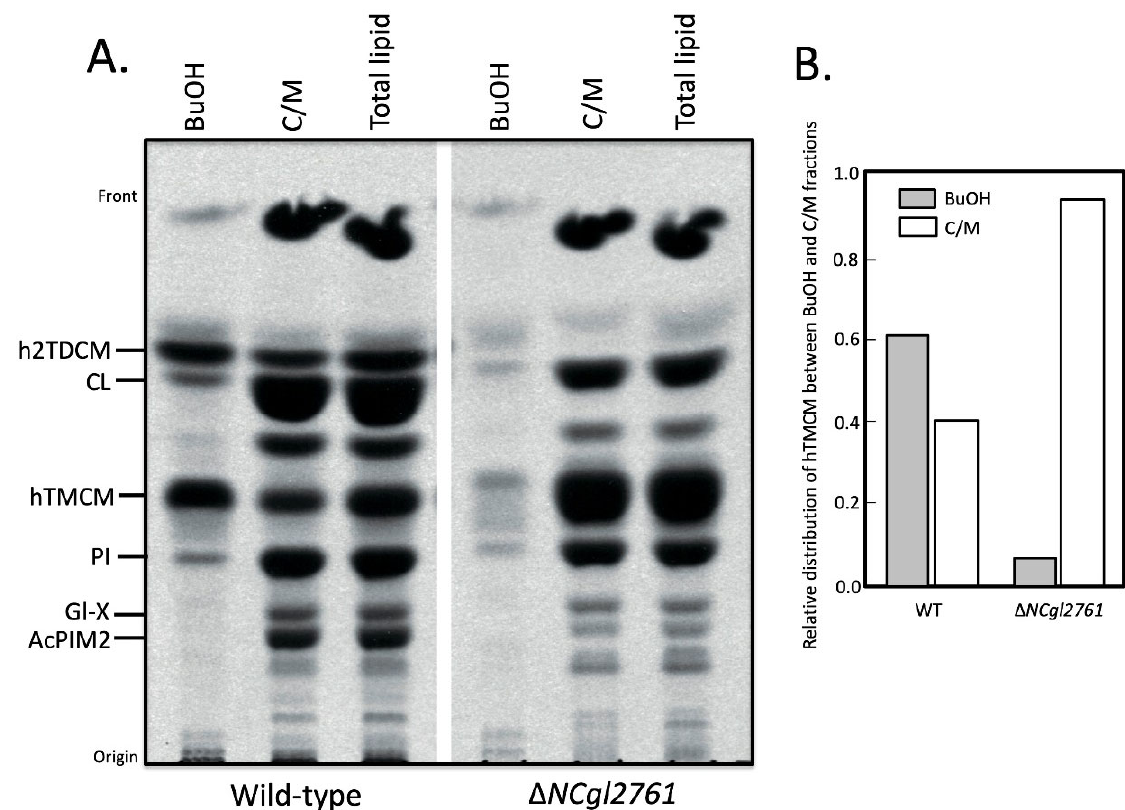
Figure 5. A C. glutamicum ∆ NCgl2761 mutant has a defect in TMCM surface transport. Wild-type and the ∆ NCgl2761 mutant were metabolically labelled with [ 14 C]-acetate and sequentially extracted in 1-butanol (BuOH) and chloroform/methanol (C/M; 2:1 v / v ). Parallel cultures were directly extracted in chloroform/methanol/water (Total lipid; 1:3:1 v / v ). The three fractions from each bacterial line were analysed by HPTLC ( A ) and labelled species detected by fluorography and quantitated ( B ).